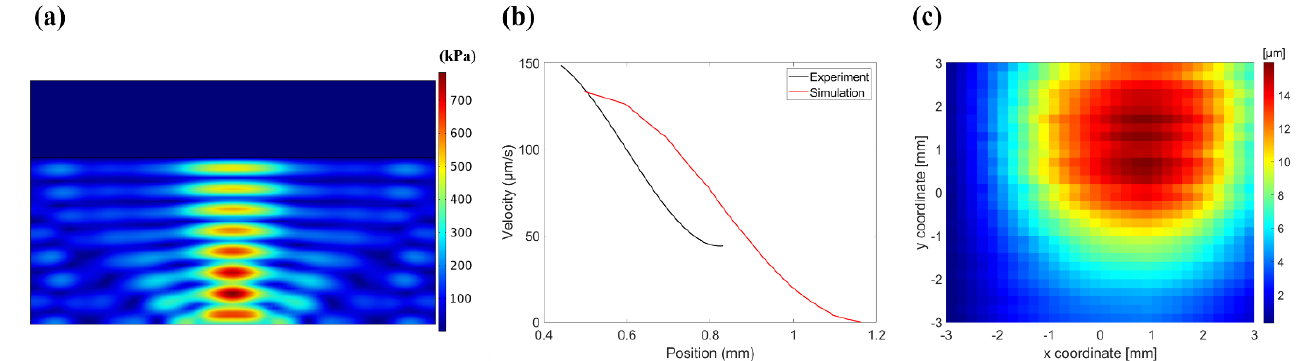
Figure 6. ( a ) Simulated pressure field in medium; ( b ) velocity comparison based on simulation and experiment locations; ( c ) measured oil height with laser pointer.